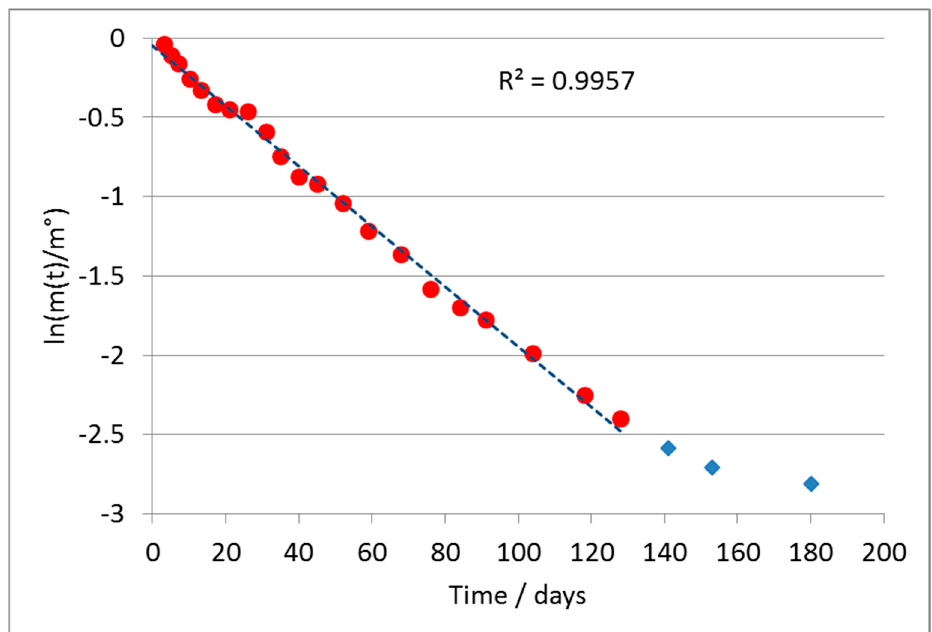
Figure 2. Linear regression of the conversion data for the A formulate according to the first-order model (Equation (4)). Blue diamonds were not included in the regression pertaining to the plateau region.